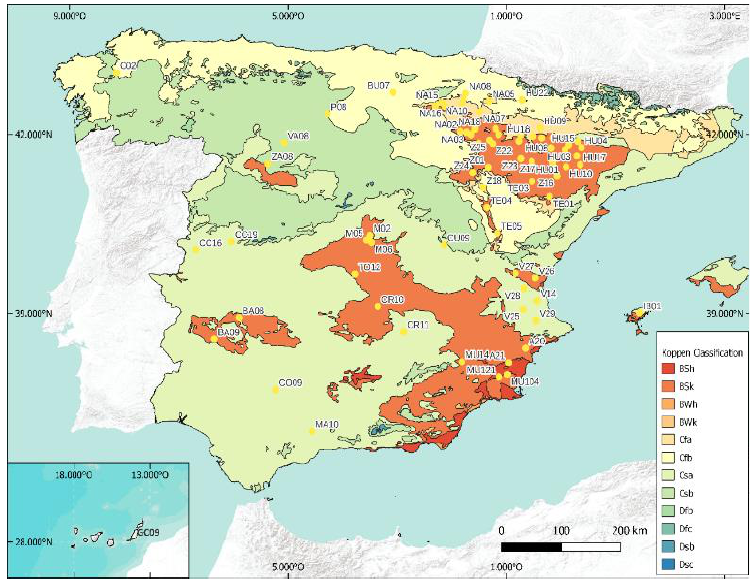
Figure 10. Köppen classification, updated from SIAR data for the years 2017 – 2020.